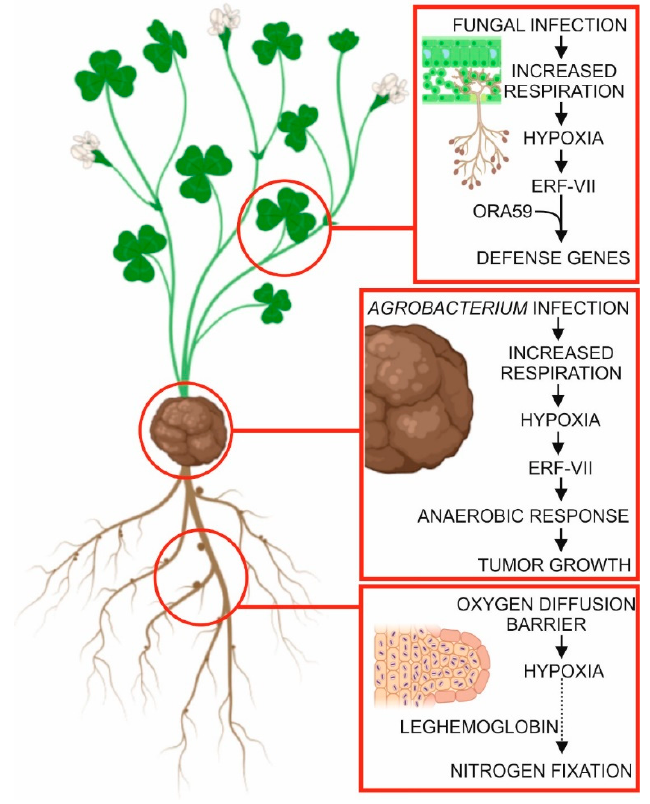
Figure 4. Local hypoxia establishment during plant–microbe interactions. Leaf infection by necrotrophic fungi results in enhanced respiration, which eventually leads to hypoxia. Under these conditions, ERF-VII proteins are stable and, through interaction with ORA59, they influence the efficacy of a plant’s response to the pathogen. Similarly, agrobacterium infection enhances respiration in the infected tissue, which leads to hypoxia. Stable ERF-VII activates the anaerobic response that favors tumor growth. In legumes, rhizobia requires hypoxic conditions, given that the activity of nitrogenase enzyme, which can fix N 2 , is inactivated by oxygen. Nodules maintain an inner low-O 2 environment thanks to the presence of a nodule O 2 diffusion barrier and by expressing O 2 -carrying symbiotic plant hemoglobins (leghemoglobin). This figure was created using BioRender [17].